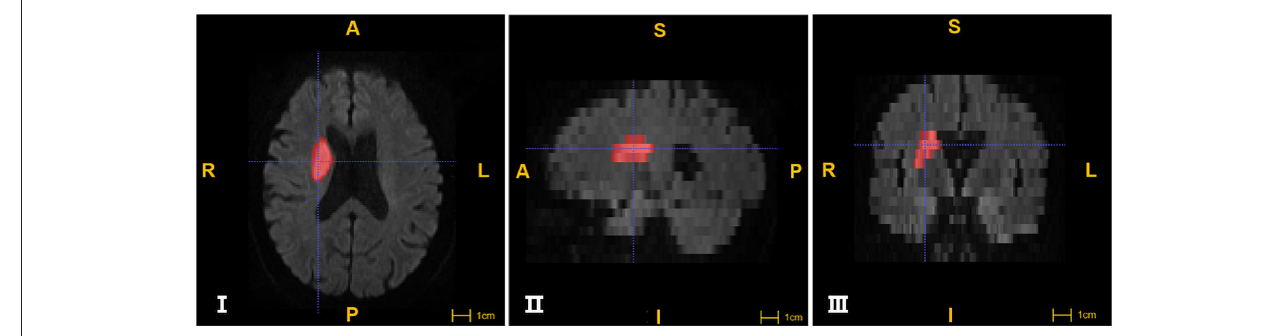
FIGURE 2 | The segmentation of Ischemic lesions through ITK-SNAP software. I, II, III images were segmented from cross section, sagittal and coronal plane respectively. The areas in red are marked as infarcts (A: anterior; P: posterior; R: right; L: left; S:superior; I: inferior).